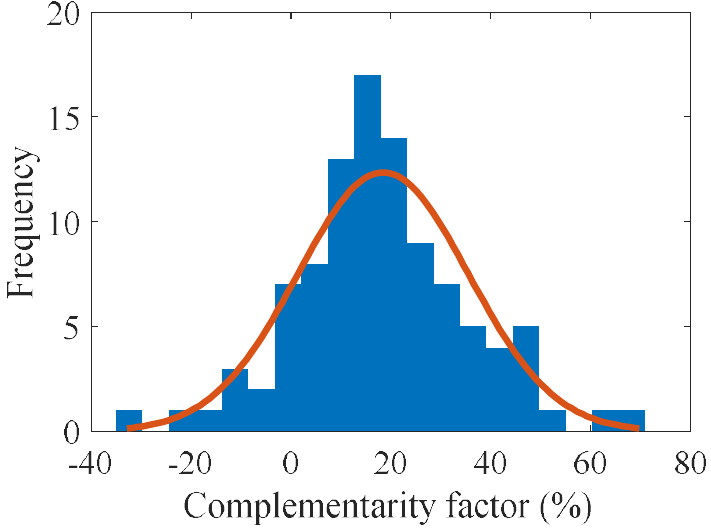
Figure 9. Histogram of complementarity factor at 2–3 pm for prosumers’ ratio of 0.25.